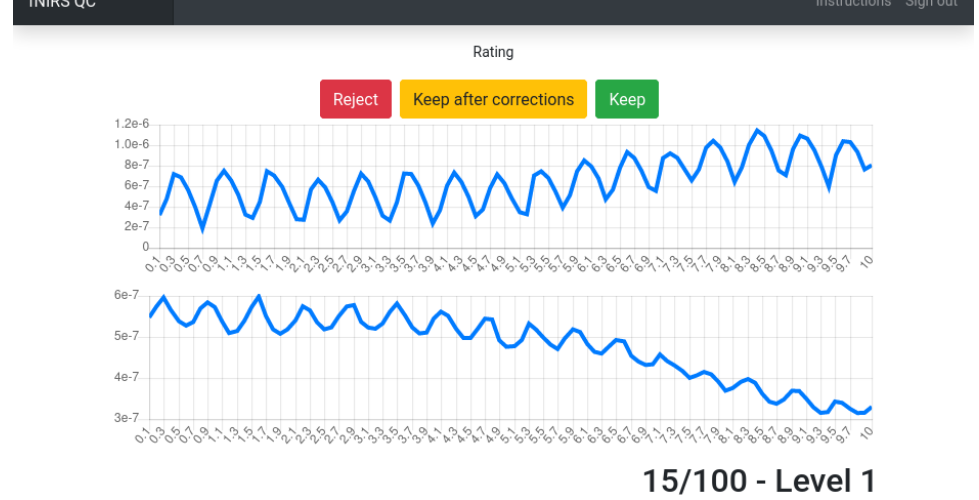
Figure 1. Screenshot of the fNIRS-QC web interface. Table 2. Breakdown of the ratings by user (N =